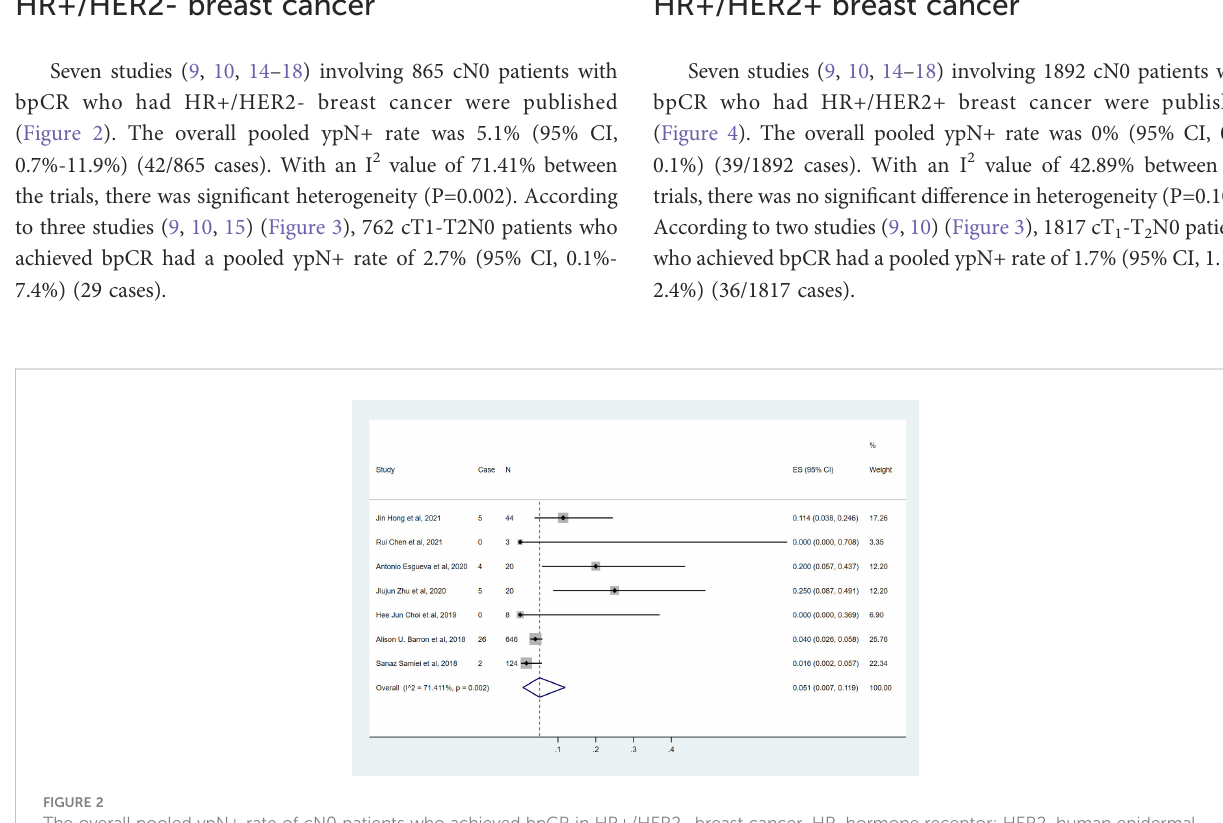
FIGURE 2 The overall pooled ypN+ rate of cN0 patients who achieved bpCR in HR+/HER2- breast cancer. HR, hormone receptor; HER2, human epidermal growth factor receptor 2. ES, effect size. CI, con fi dence interval. Effect size was used to estimate the ypN+ rate of each study. Con fi dence intervals determine the consistency and reliability of the mean estimated effect size. Diamonds indicate effect